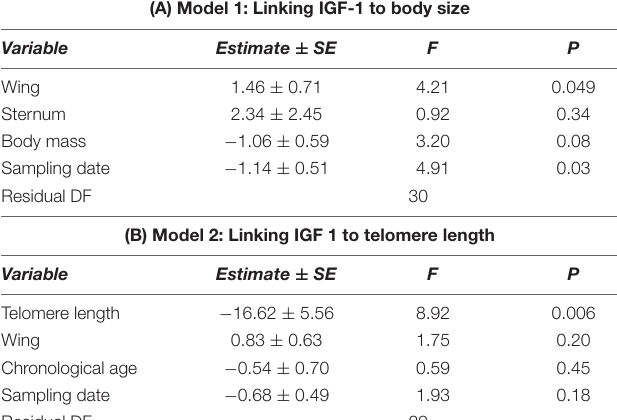
TABLE 1 | Linear models showing positive association between plasma levels of insulin-like growth factor 1 and wing length (model 1), and negative relation between plasma levels of insulin-like growth factor 1 and relative telomere length (model 2), in adult Alpine